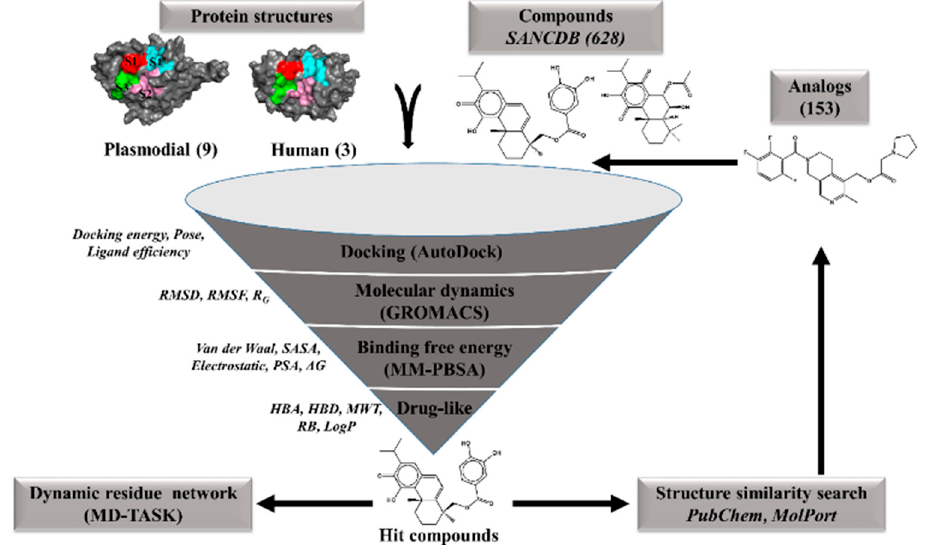
Figure 9. A graphical workflow of the computational approaches used in the identification of potential hits against P. falciparum FP-2 and FP-3 proteins and their homologs from other plasmodial species.